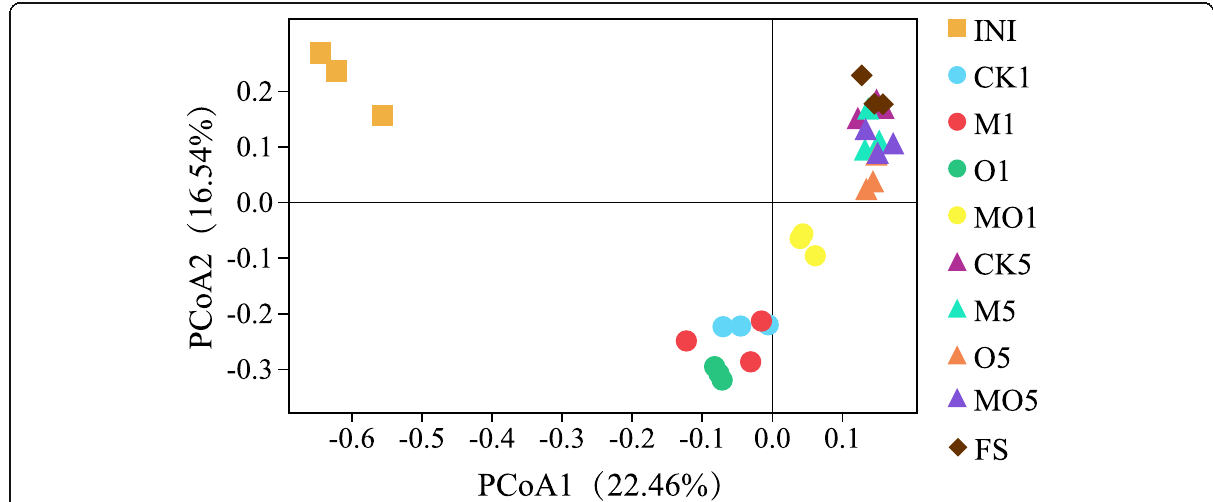
Fig. 3 Principal coordinates analysis (PCoA) used for evaluating the general microbial community compositions from the reclaimed site, un- reclaimed soil (INI), and normal farmland soil